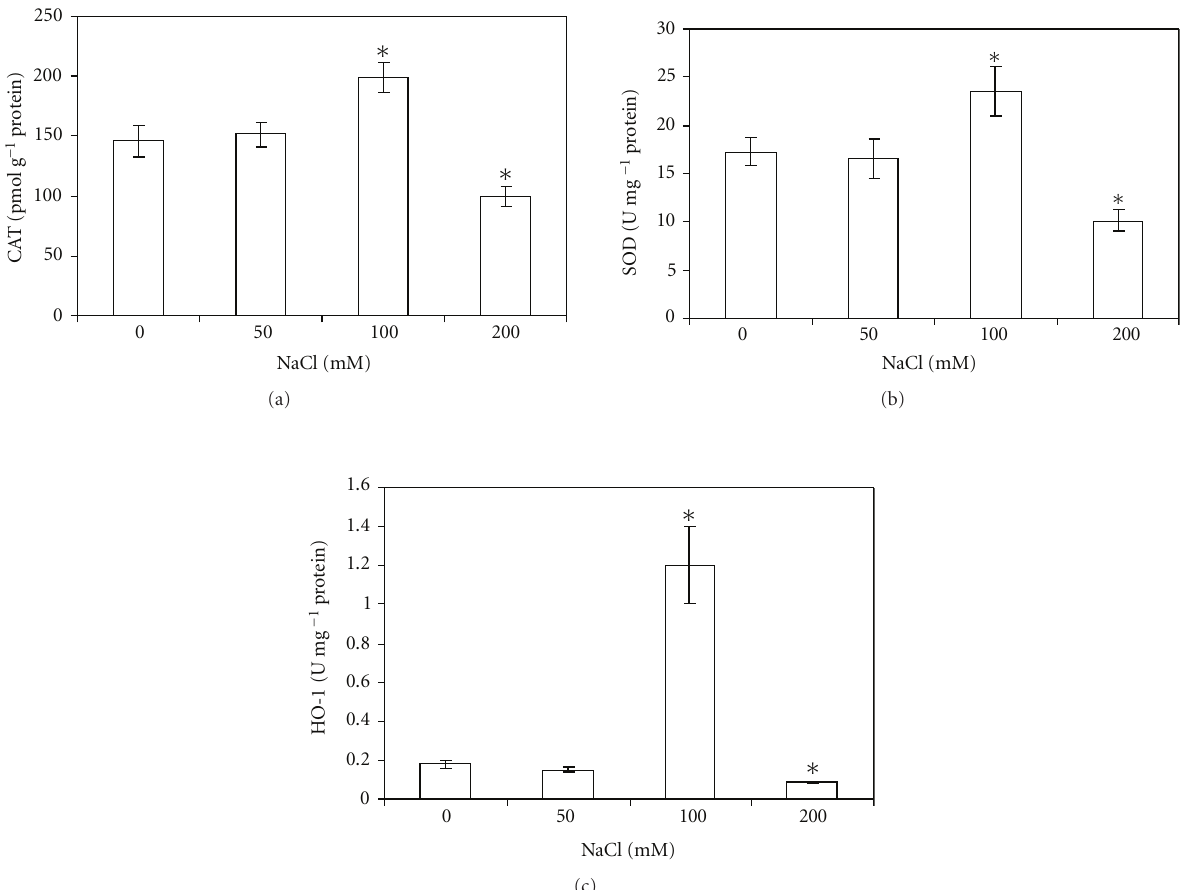
Figure 2: E ff ect of di ff erent salt concentrations on classical antioxidant and heme oxygenase enzyme activities: (a) catalase, (b) superoxide dismutase, and (c) heme oxygenase. Enzymes activities were measured as described in Experimental section. Values are the means of four di ff erent experiments ( n = 4), and bars indicate SD, ∗ significant di ff erences ( P < . 05) compared to control, according to Tukey’s multiple range test.